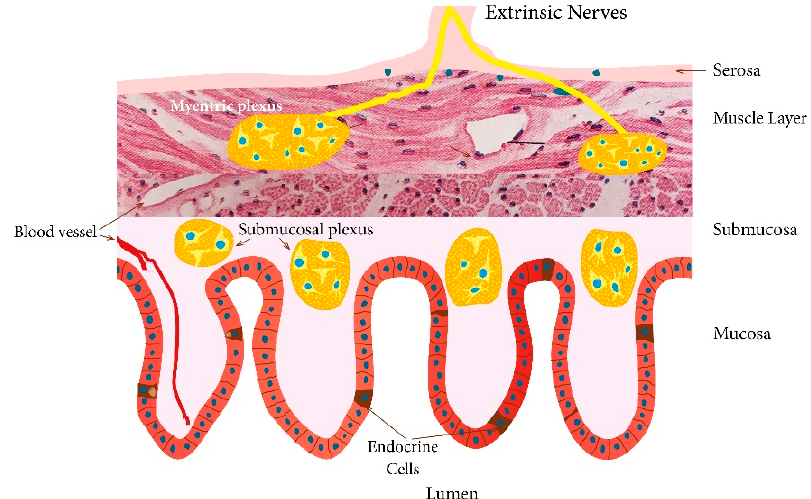
Figure 1. Schematic illustration of the gut endocrine cells. The endocrine cells are scattered among the epithelial cells of the mucosa facing the gut lumen. These cells secret at least 14 different hormones that regulate gut motility, secretion, absorption, visceral sensitivity, local immune defense, cell proliferation, and appetite. These hormones also interact and integrate with the enteric, autonomic, and central nervous systems.